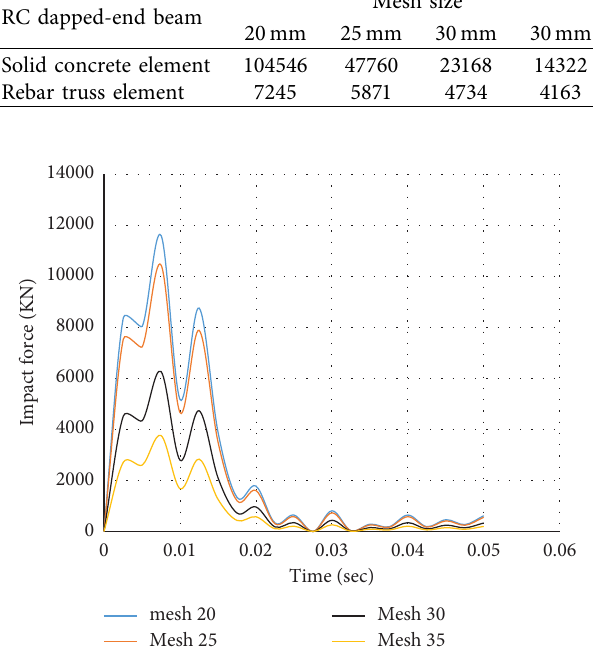
Figure 6: Infuence of mesh size on the impact force on dapped end